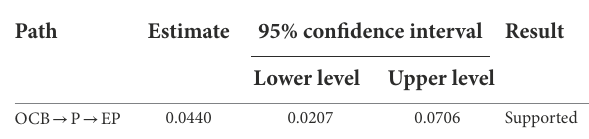
TABLE 6 Mediation